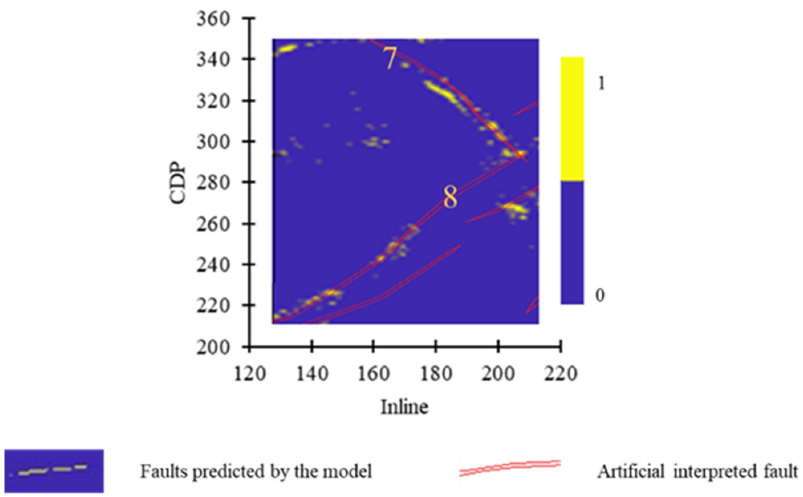
Figure 12. Prediction result of Fault 7 and Fault 8 by Model 2.